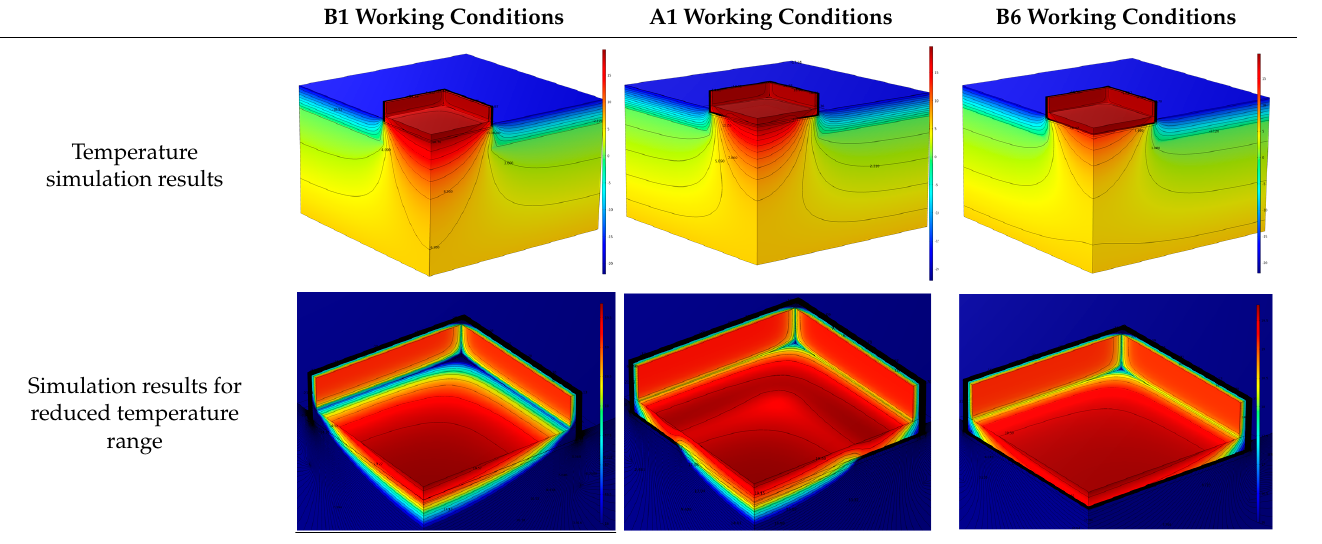
Figure 7. Group B model temperature distribution map. ( a ) Model B1 temperature distribution, ( b ) Model B2 temperature distribution, ( c ) Model B3 temperature distribution, ( d ) Model B4 tempera- ture distribution, ( e ) Model B5 temperature distribution, ( f ) Model B6 temperature distribution, ( g ) Model B7 temperature distribution, ( h ) Model B8 temperature distribution, ( i ) Model B9 tempera- ture distribution, ( j ) Model B10 temperature distribution ( k ) B11 model temperature profile, ( l ) B12 model temperature profile, ( m ) B13 model temperature profile, ( n ) B14 model temperature profile, ( o ) B15 model temperature profile, ( p ) B16 model temperature profile, ( q ) B1 heat flow direction profile, ( r ) A1 heat flow direction profile, ( s ) B6 heat flow direction profile. Table 4. Temperature distribution of B1, A1, and B6 working conditions.